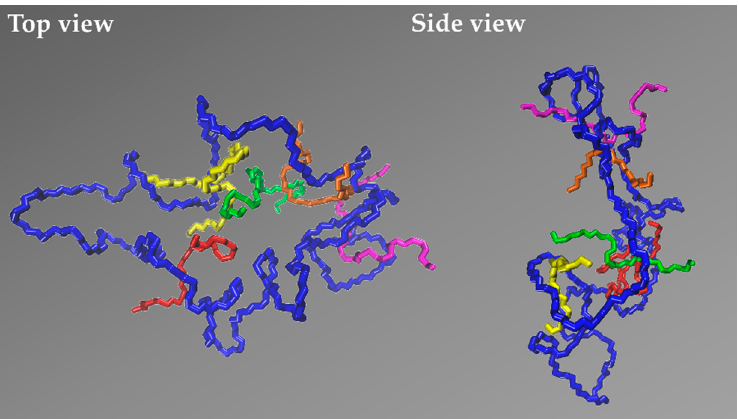
Figure 7. Atomistic snapshot of a multiply threaded ring from the MD simulation with the PEO-5k blend at φ L = 0.5. The blue ring is simultaneously threaded by five linear chains (shown in red, yellow, green, orange, and magenta). For simplicity, only the parts of the linear chains involved in the threading are shown.